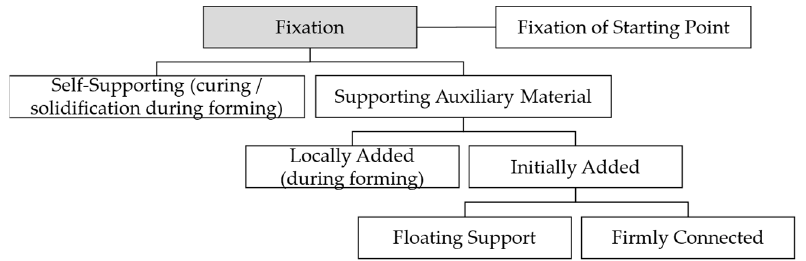
Figure 5. Possible process alternatives for fixation of the fabric.